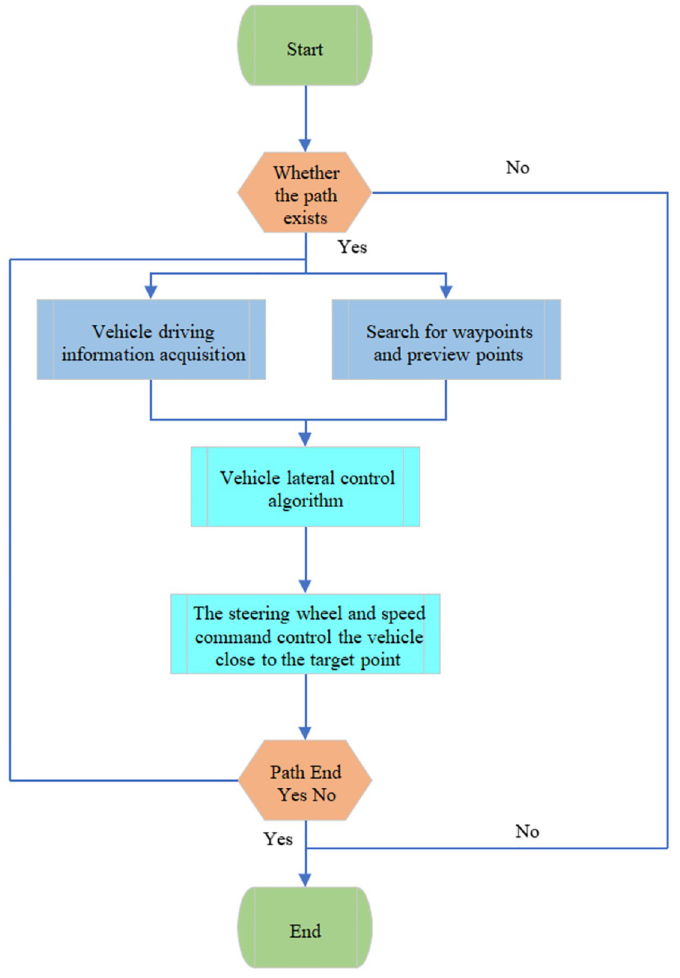
Fig 7. Basic flow of the path-tracing